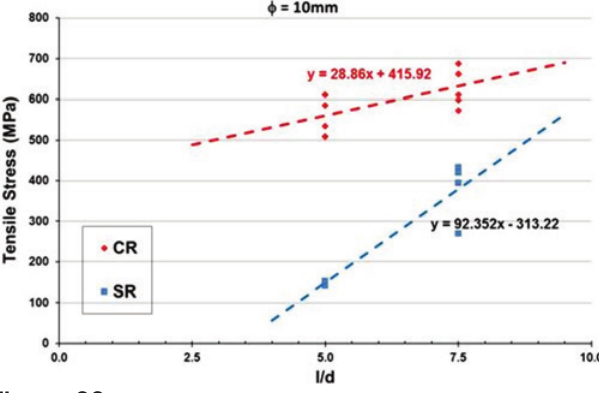
Figure 23 Bar Tensile Stress - l /d relationships, d=16mm